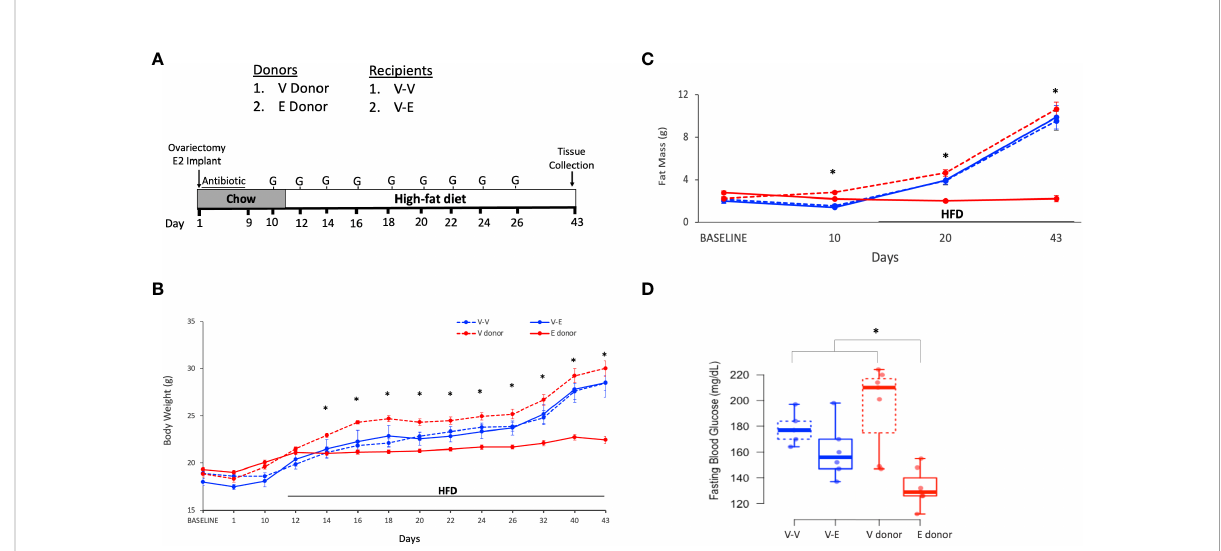
FIGURE 1 Estradiol treatment but not fecal microbiota transplant (FMT), attenuated obesity and hyperglycemia in female mice on HFD. (A) : FMT and cohousing study design and timeline. Mice were fed phytoestrogen-free chow till D11, then switched to HFD. Mice treated with E2 (E donor, n = 7) or Veh (V donor, n = 7) were used as FMT donors. All recipients received Veh implants. V-V and V-E recipients got FMT from V donors or E donors, respectively. Recipient mice were administered antibiotic cocktail for 9 days and starting on D10, were orally gavaged with 9 doses of FMT, on alternate days. G denotes FMT gavage days. (B) Body weight; (C) Fat mass. For (B, C) , repeated measures ANOVA, separately on recipients and donors, followed by a t-test. *denotes p < 0.05 between E2 donors and Veh donors). (D) 5h-fasting blood glucose on D19, after one week on HFD. Two-way ANOVA followed by Tukey post-hoc (*p < 0.05). V donor, mice with Veh implants used as FMT donors; E donor, E2-treated mice used as FMT donors; V-V, Veh mice receiving FMT from V donor; V-E, Veh mice receiving FMT from E